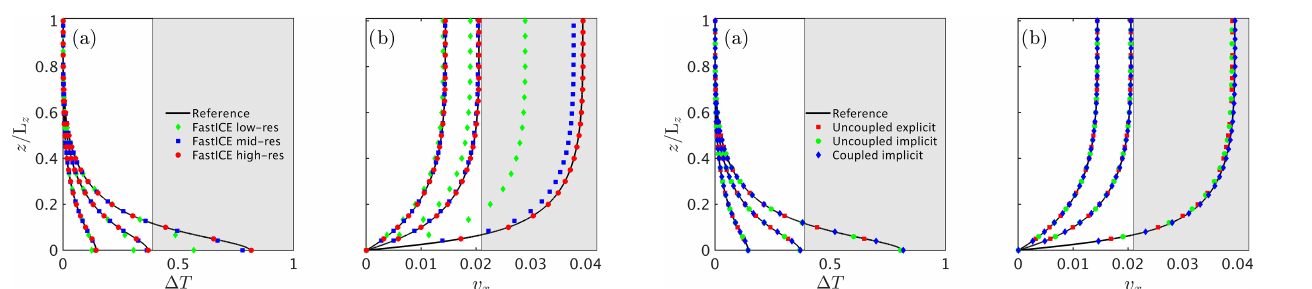
Figure 11. Non-dimensional simulation results for (a) the temper- ature deviation T and (b) the horizontal velocity component v x to evaluate different numerical time integration schemes. We consider three non-dimensional times 1 × 10 8 , 2 × 10 8 and 2 . 9 × 10 8 and compare our numerical estimates to the reference model. As before, the shaded areas correspond to the part of the solution that is above the melting temperature, since we neglect phase transitions in this